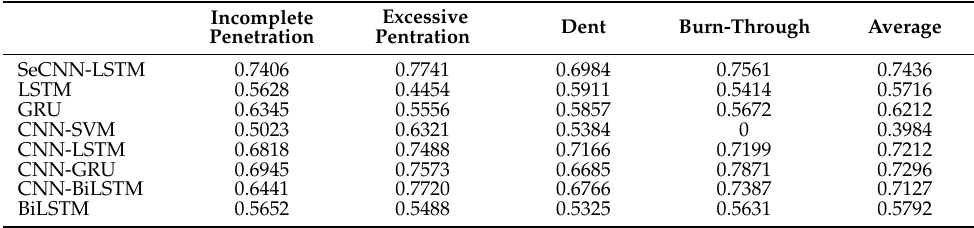
The F1-score indicates the best balance between precision and recall. As shown in Table 6, comparing the F1-score of each sample of the eight models, the model described in this paper showed the best performance. Table 6. F1 score